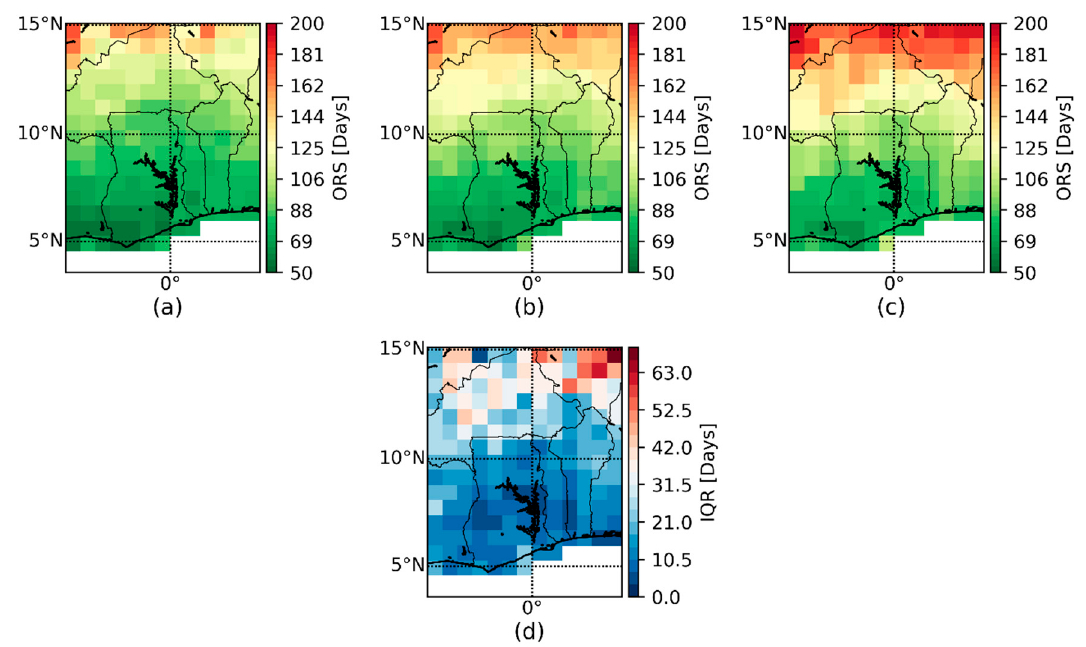
Figure 10. ( a ) Early ORS (0.33th quantile), ( b ) mean ORS and ( c ) late ORS (0.66th quantile) in 2001 for SYS4 (Julian day) over 15 ensemble members (initialized in February) and ( d ) the interquartile range (IQR; Julian days) between early ORS (0.33th quantile) and late ORS (0.66th quantile) in 2001 for SYS4 over 15 ensemble members (initialized in February).